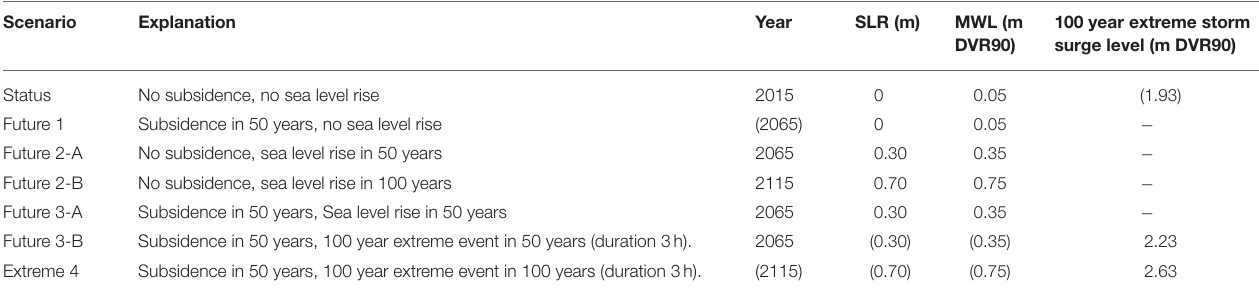
TABLE 1 | Scenarios modeled in MIKE for a range of combinations of precipitation, sea level rise, and extreme water levels with and without land movement, and looking 50 and 100 years